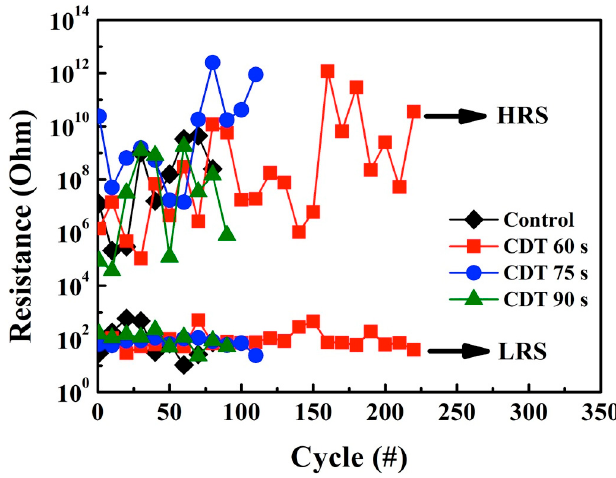
Figure 8. Endurance characteristics of the control and Cu-CDT ReRAM devices in the LRS and HRS.